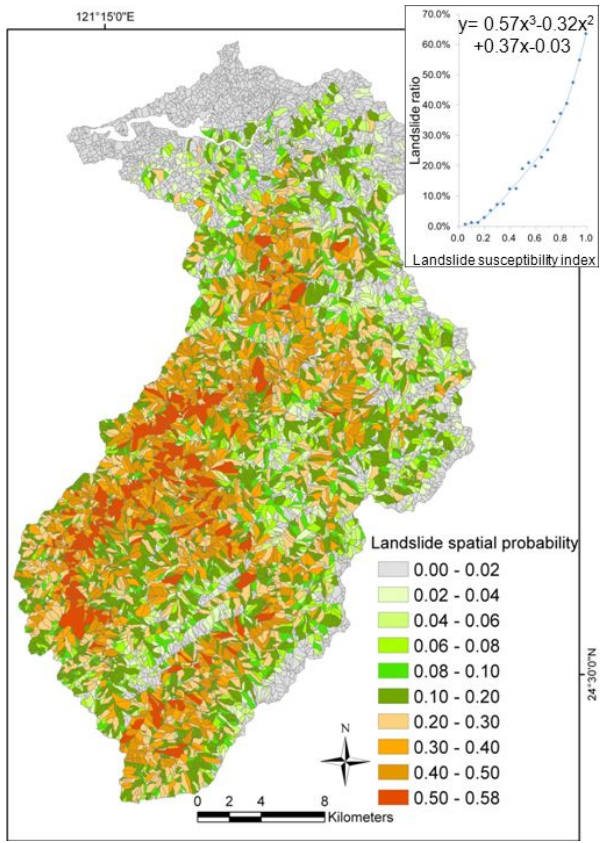
Fig. 8. The landslide probability during the next 1yr period obtained using the Poisson probability model.